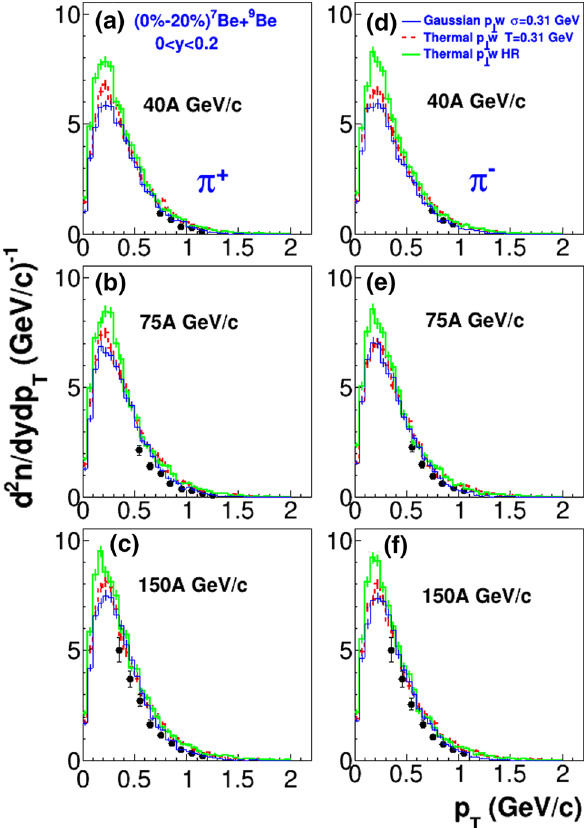
Fig. 7 Same as Fig. 6 but for the transverse momentum spectra of π ± at mid-rapidity (0 < y < 0 .